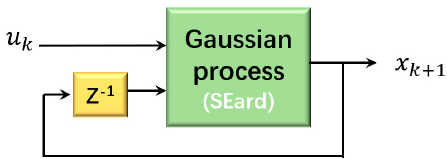
Figure 7. The GP-NARX model, where the extracted EMG feature u k is the input and the joint vector x k + 1 is the output